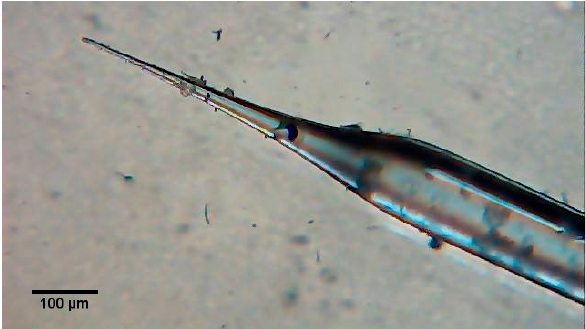
Figure 3. Microscope image of the tapered fiber tip.